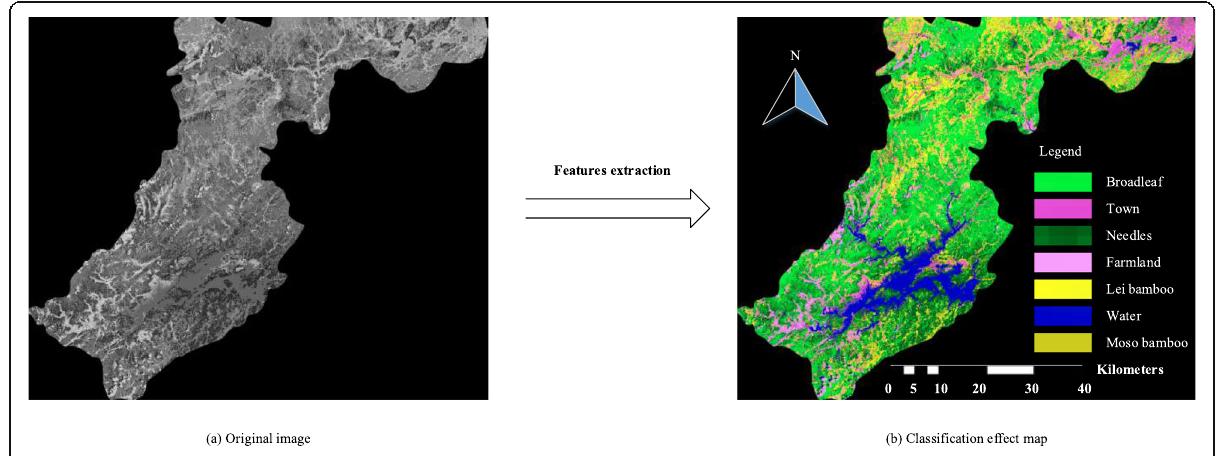
Fig. 5 Classification effect map of Landsat 8 image obtained by RFMD